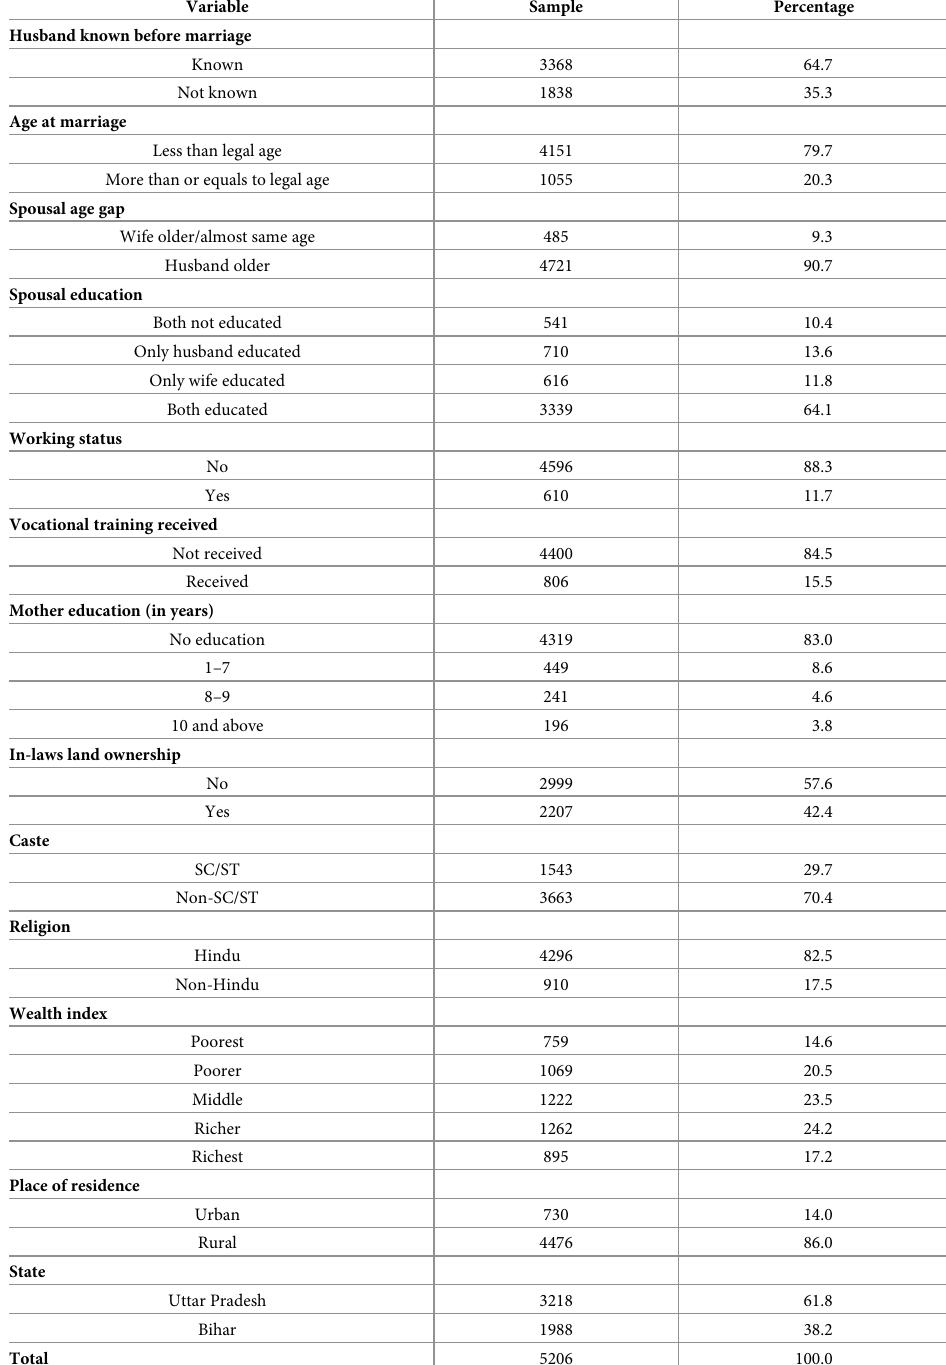
Table 1. Socio-demographic profile of married adolescents (15–19